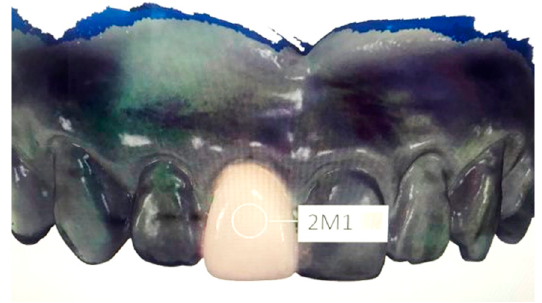
Figure 6. Shade selection with Trios 3 Basic. A shade measurement circle was placed on the buccal side at the middle third of the tooth.